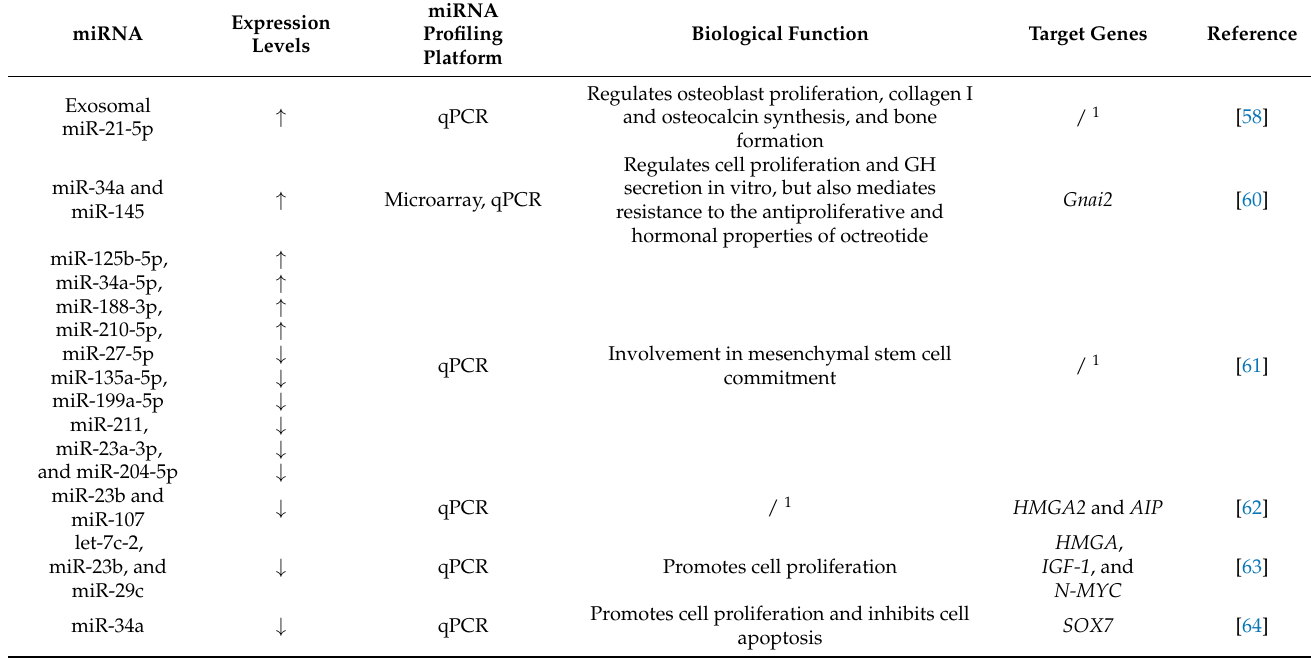
Table 4. Summary of differentially expressed miRNAs with their validated targets in somatotropinomas. miRNA